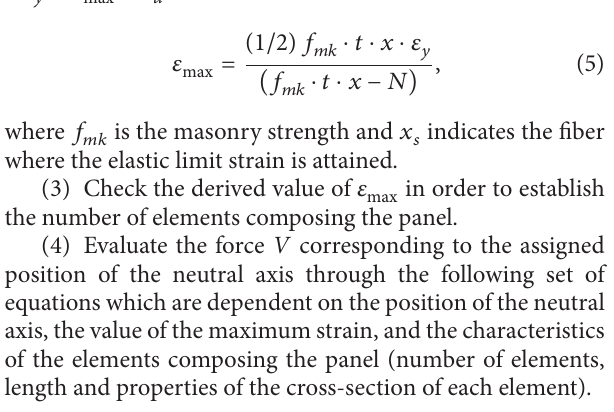
in the sections cannot exceed the ultimate value 𝜀 𝑢 which indicates the failure condition for the panel. In both cases, the maximum strain can assume values less or greater than the yield strain 𝜀 𝑦 ; when 𝜀 max exceeds 𝜀 𝑦 , three elements are necessary for schematizing the panel (Figure 2(c)).